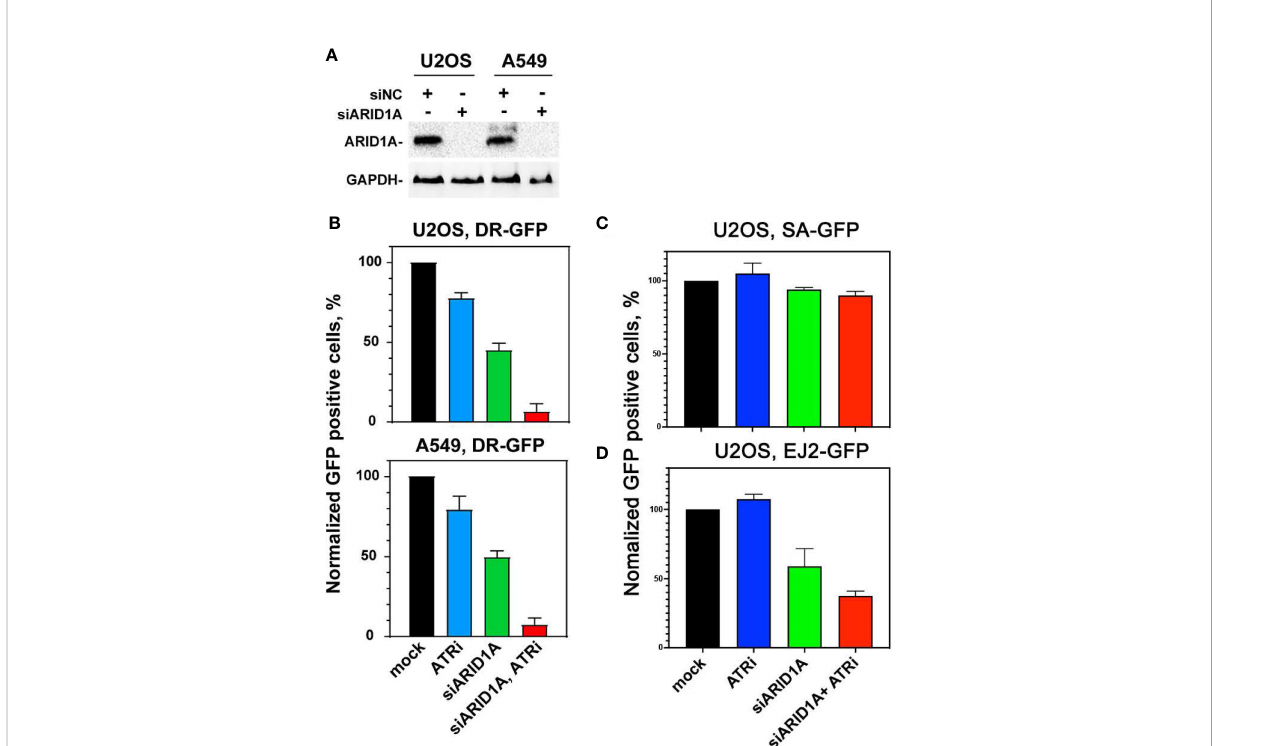
FIGURE 5 Effect of ATRi on HR repair in reporter cell lines. (A) Western blot results of ARID1A knock-down in DR-GFP-U2OS and DR-GFP-A549 reporter cells; GAPDH was used as an internal control. (B) Normalized GFP expression in DR-GFP- U2OS and DR-GFP-A549 reporter cells after treatment with control siRNA (mock), 20 nM VE822 (ATRi), ARID1A speci fi c siRNA (siARID1A) and ATRi after knock-down of ARID1A (siARID1A, ATRi). (C) Normalized GFP expression in SA-GFP- U2OS reporter cells after treatment with control siRNA (mock), 20 nM VE822 (ATRi), ARID1A speci fi c siRNA (siARID1A) and ATRi after knock-down of ARID1A (siARID1A, ATRi). (D) Normalized GFP expression in EJ2-GFP- U2OS reporter cells after treatment with control siRNA (mock), 20 nM VE822 (ATRi), ARID1A speci fi c siRNA (siARID1A) and ATRi after knock-down of ARID1A (siARID1A, ATRi).Results of 3 independent experiments are shown for CRC cell